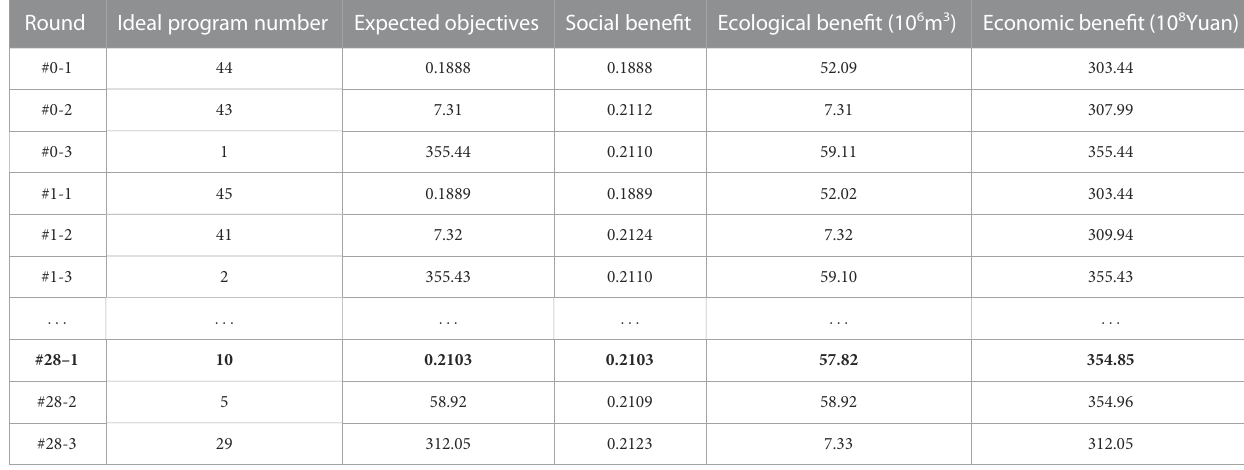
TABLE 3 The process of optimizing water resource allocation at city and county levels in low fl ow year. Round Ideal program